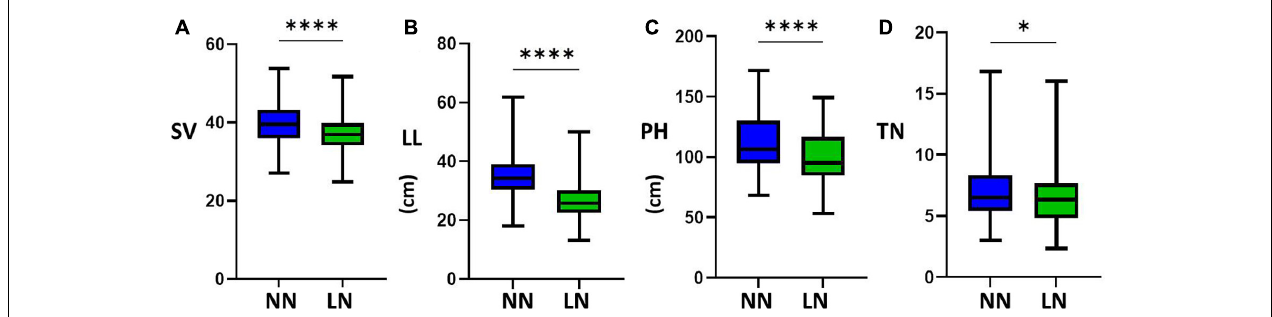
FIGURE 1 | Boxplots of the mean amounts of four nitrogen-use efficiency (NUE)-related agronomic traits of different accessions under the normal nitrogen (NN) level and the low nitrogen (LN) level. Phenotypic traits of (A) soil and plant analyzer development value (SV), (B) leaf length (LL), (C) plant height (PH), and (D) tiller number (TN) (**** P < 0.0001; * P < 0.05).